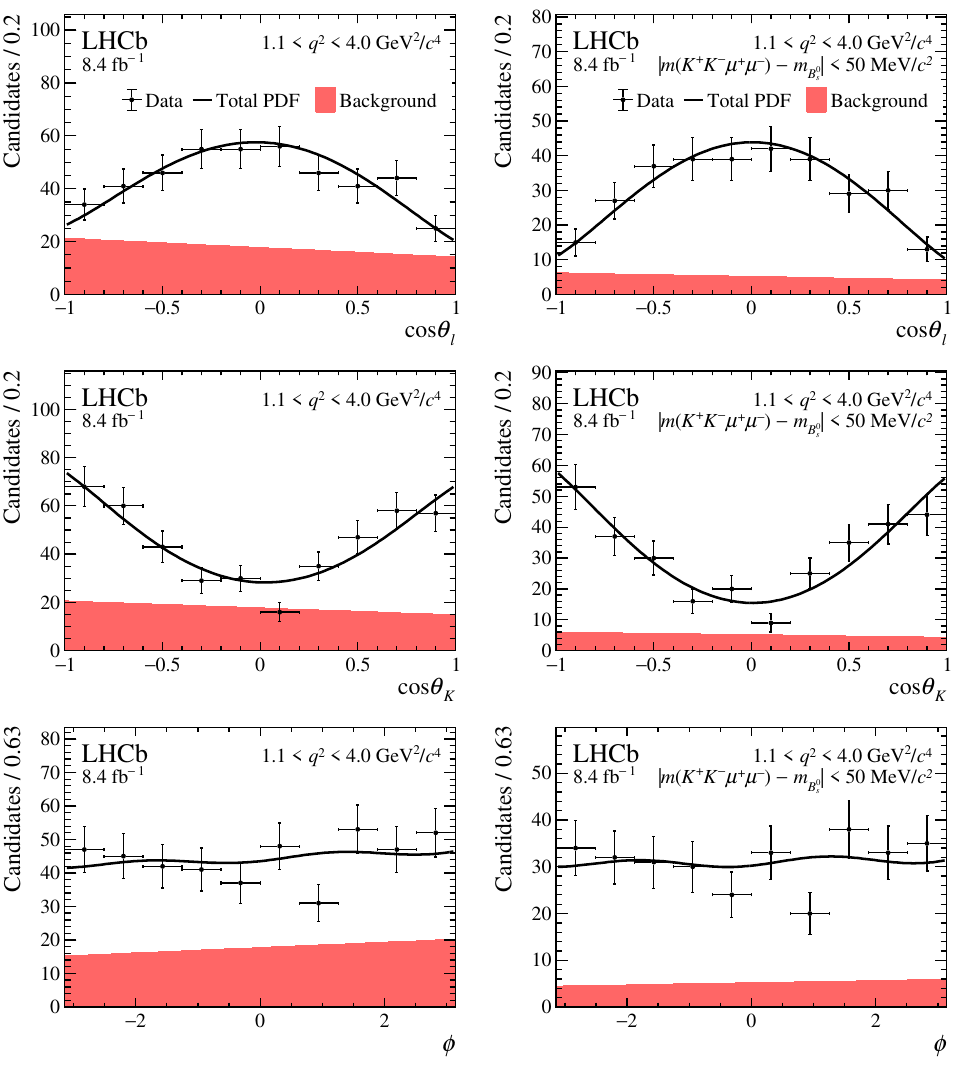
Figure 6 . Projections in the region 1 . 1 < q 2 < 4 . 0 GeV 2 /c 4 for the angular distributions of the combined 2011–2012, 2016 and 2017–2018 data set. The data are overlaid with the projection of the combined PDF. The red shaded area indicates the background component and the solid black line the total PDF. The angular projections are given for candidates in (left) the entire mass region used to determine the observables in this paper and (right) the signal mass window ± 50 MeV/ c 2 around the known B 0 s